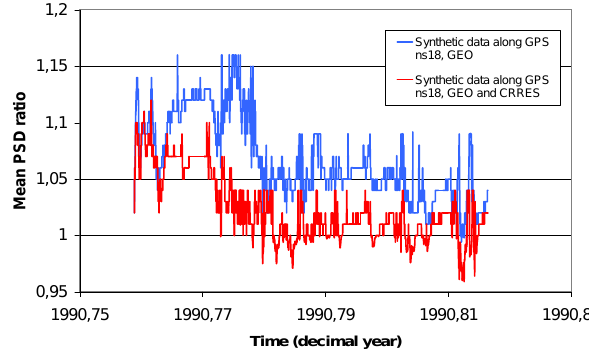
Fig. 10. Mean ratio over the full simulation grid of the mean pre- dicted PSD by the ensemble to the “true” PSD versus time in an identical-twin configuration.